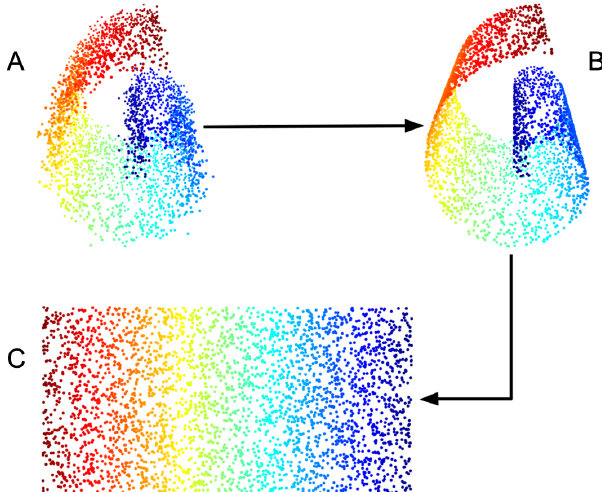
FIG. 1. Data dimensionality reduction by manifold learning. (A) shows a three-dimensional dataset that is close to lying on a two-dimensional surfacewhich is embedded within R 3 . (B) shows the projection of the source data onto this embedded manifold, which is folded into a Swiss roll in the original 3D space. (C) shows the distribution of the data across the embedded manifold, providing a 2D visual representation of the source